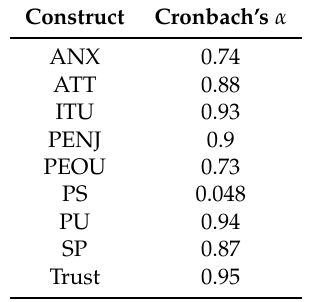
Table 4. Cronbach’s α values for Almere